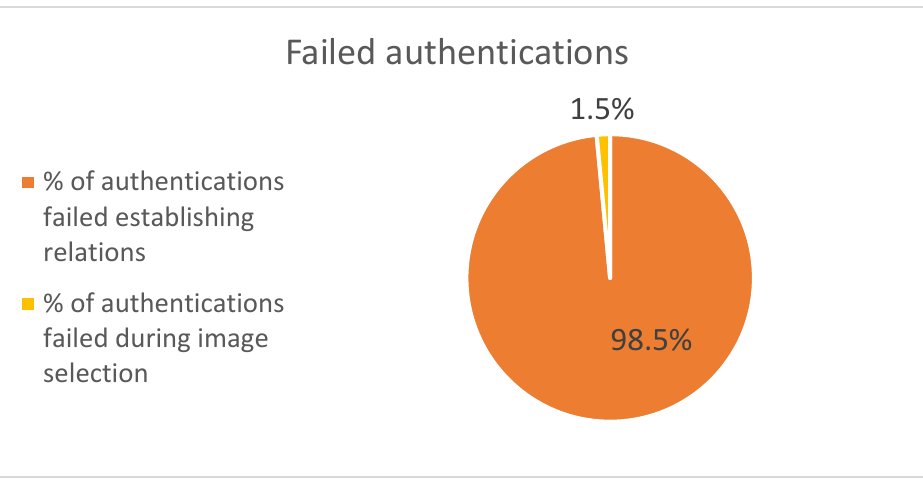
Table 2. Authentication process information.